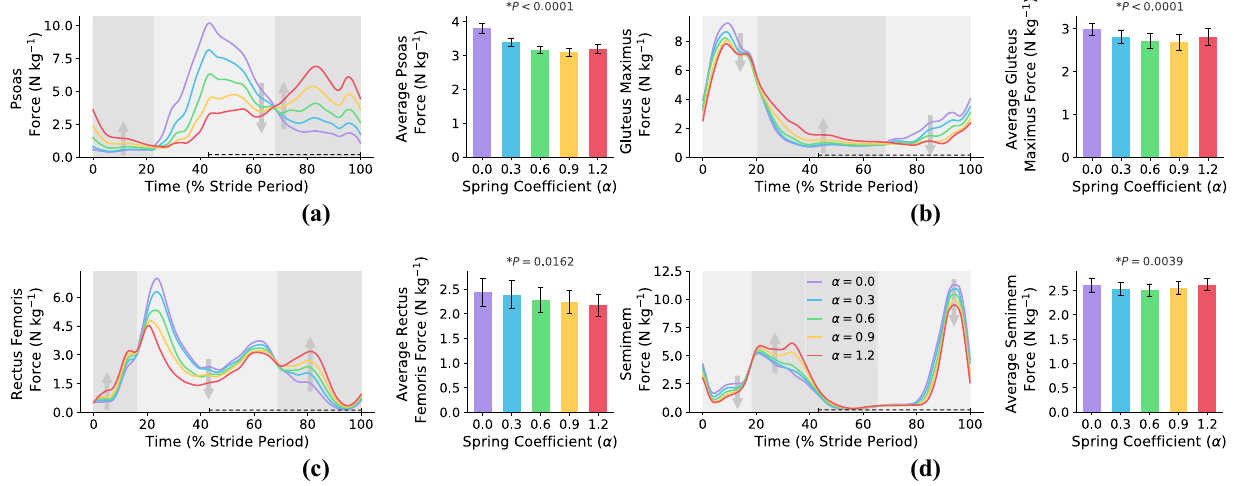
Figure 4. Hip muscles’ forces . This figure shows the effects of exoskeleton augmentation on the main hip muscles’ forces and their average over the whole stride. The start of the gait cycle is at the heel-strike instant of the right leg, and all of the figures are for the right leg. The swing phase is shown with a dashed line over the horizontal axes. The background color code for all of the sub-figures is: light(dark) gray means muscle force reduction(increment). As can be seen, exoskeleton augmentation changes the force profiles of all hip muscles. ( a , b ) show main hip antagonistic mono-articular muscles where Psoas is a hip flexor, and Gluteus Maximus is a hip extensor. The minimum of average Psoas and Gluteus Maximus forces are on α = 0.8 , which yields to 19% and 10% reductions. And, the reductions of average Psoas and Gluteus Maximus forces for α ∗ = 0.6 are 17.4% and 8.9% , respectively. ( c , d ) Show main hip antagonistic bi-articular muscles where Rectus Femoris and Semimembranosus are hip flexor and extensor, respectively. The minimum of average Rectus Femoris and Semimembranosus forces are on α = 1.4 and α = 0.6 , which yields to 11.7% and 4.6% reductions. And, the reductions of average Rectus Femoris and Semimembranosus forces for α ∗ = 0.6 are 6.5% and 4.2% , respectively. N = 7 ; bars, mean; error bars, s.e.m; P values, ANOVA (random effect: participant; fixed effects: spring coefficient; significance level = 0.05